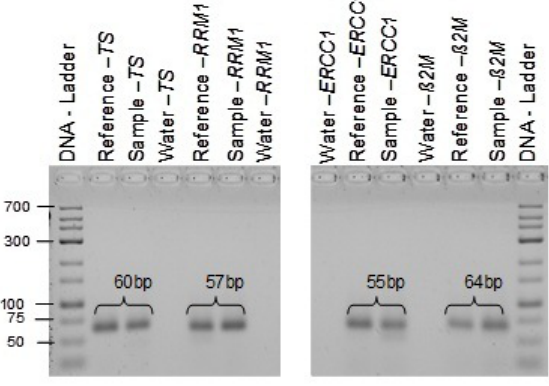
Figure 9. Confirmation of primer specificity after cDNA-amplification.